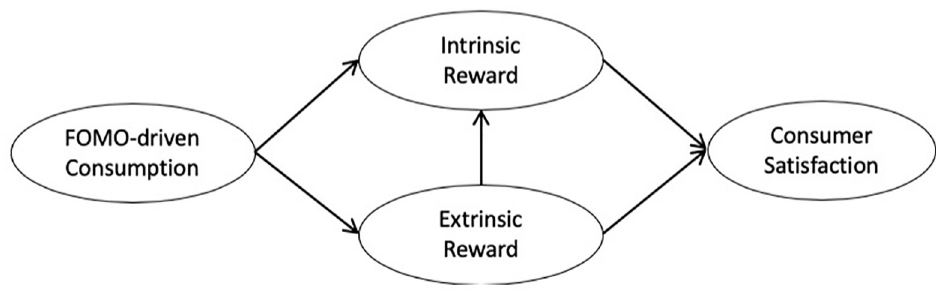
Fig 2. Structural Model of Study